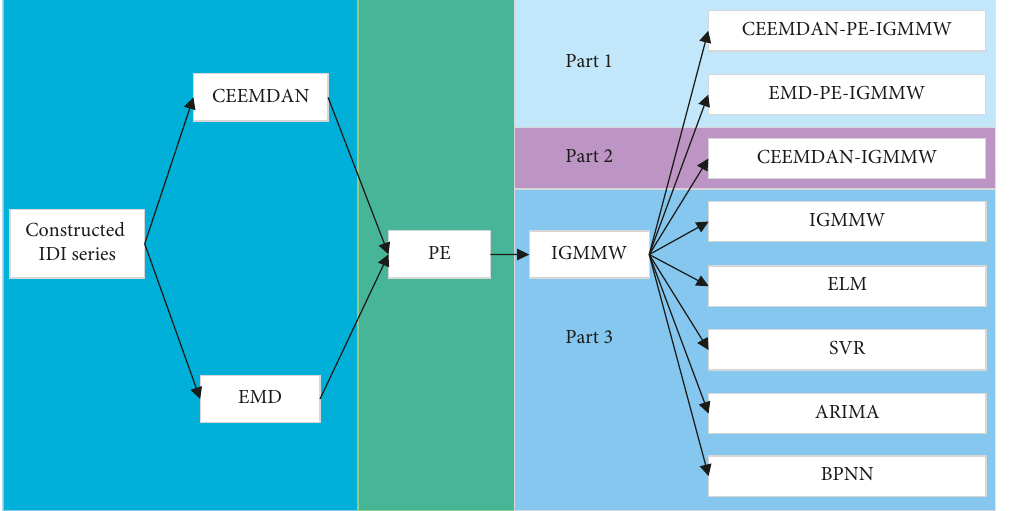
Figure 13: Description of the model